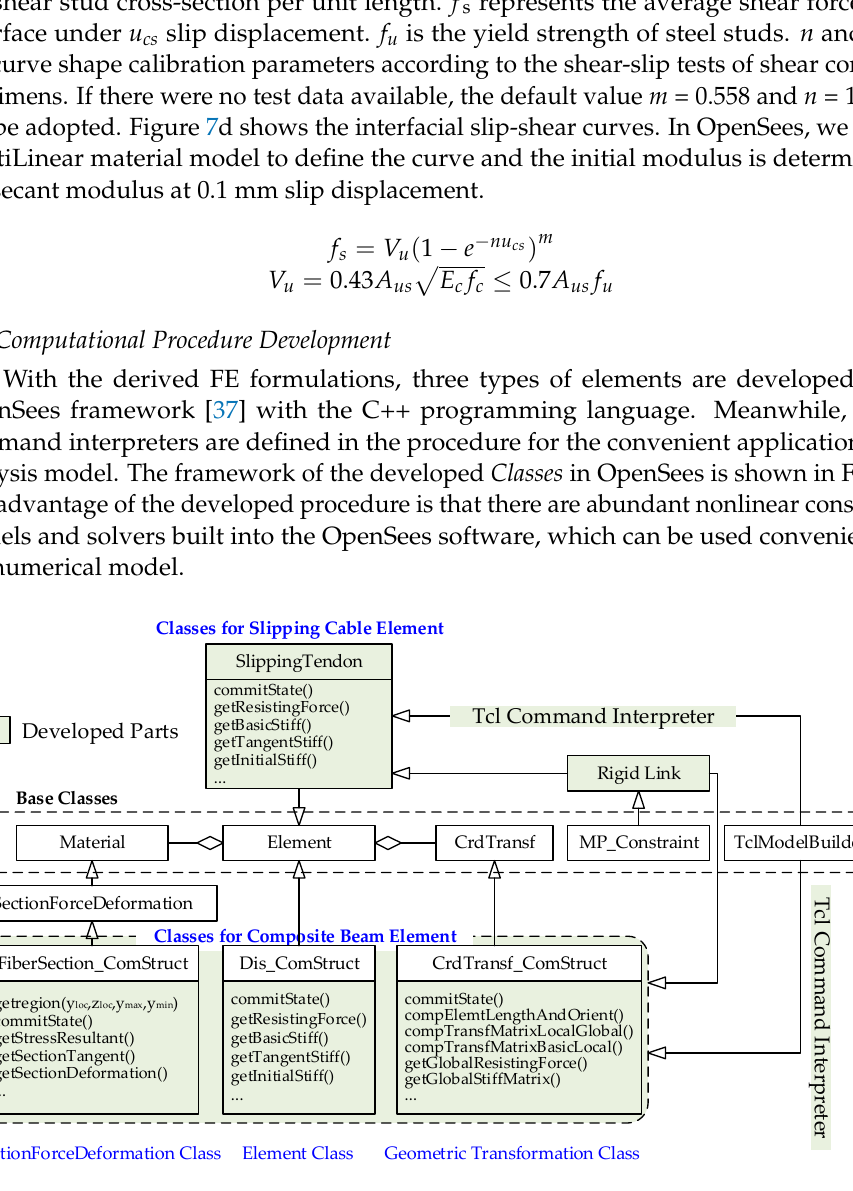
Figure 8. The framework developed in OpenSees.